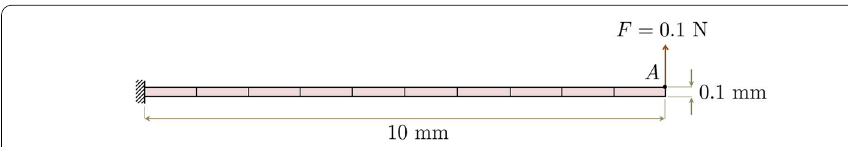
Fig. 6 Thin beam, geometry, boundary conditions, loading and discretization